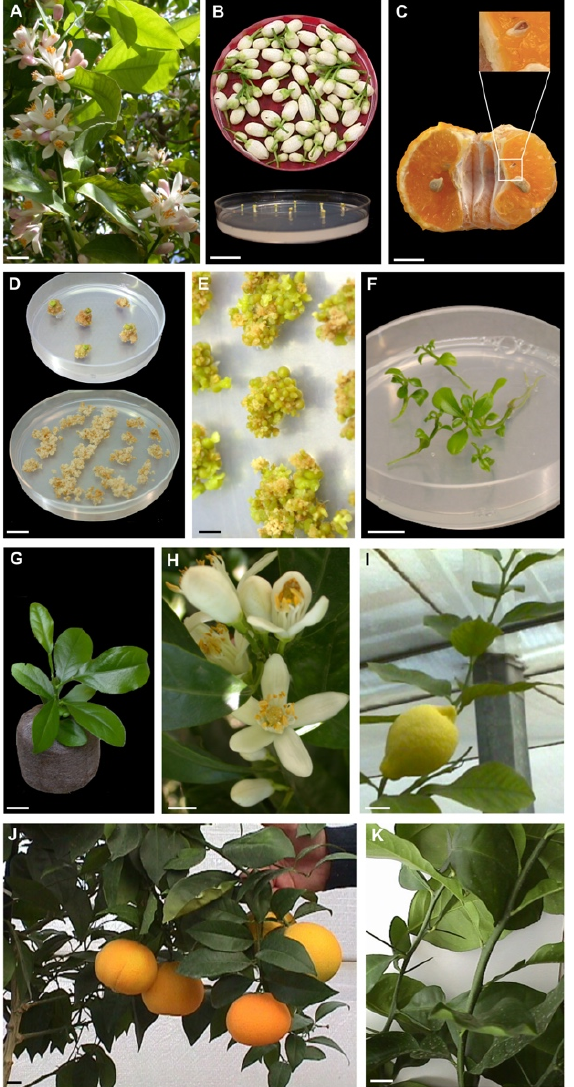
Figure 1. Somatic embryogenesis and plant regeneration in Citrus . ( A ) Representative blooming Citrus (lemon) (bar = 2 cm); ( B ) Stigma/style explants dissected from orange flowers collected before opening (bar = 2 cm); ( C ) Undeveloped ovule in open pollinated fruit of mandarin harvested 6 months after anthesis (bar = 1 cm); ( D ) Creamy-white callus from the stigma/style and undeveloped ovule explants (bar = 2 cm); ( E ) Somatic embryos generated after 3–5 months of culture initiation at the surface of stigma/style explant-derived callus (bar = 3 mm); ( F ) Germinated somatic embryos growing on MS medium (bar = 1 cm); ( G ) Somatic embryo-derived plant of sweet orange transferred to Jiffy peat pellet (bar = 1 cm); ( H ) Sweet orange stigma/stile regenerants flowering under greenhouse condition (bar = 1 cm); ( I , J ) Fruits of ‘Femminello comune’ lemon and ‘Brasiliano NL 92’ sweet orange produced by three years old stigma/style regenerated plants growing in greenhouse (bar = 2 cm); ( K ) Thorny and thornless sour orange shoots from three years old stigma/style regenerants (bar = 2 cm).